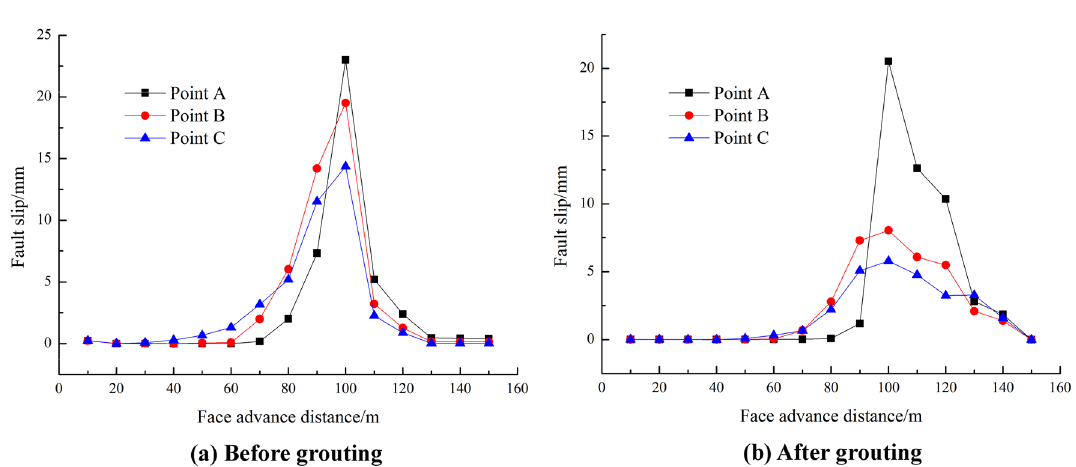
Figure 9. The amount of fault slip before and after